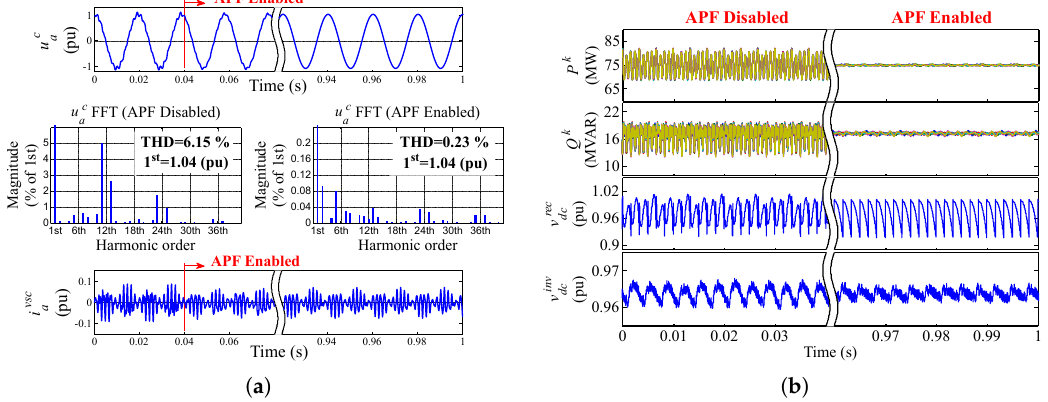
Figure 8. Steady-state active power filtering (APF) performance at the rated power: ( a ) phase a of the capacitor bank voltage and its fast Fourier transform (FFT) spectrum, and phase a of the VSC current; ( b ) the WTs’ active and reactive powers, rectifier dc-voltage, and onshore inverter